Question: Sum up the contents of this chart in one sentence.
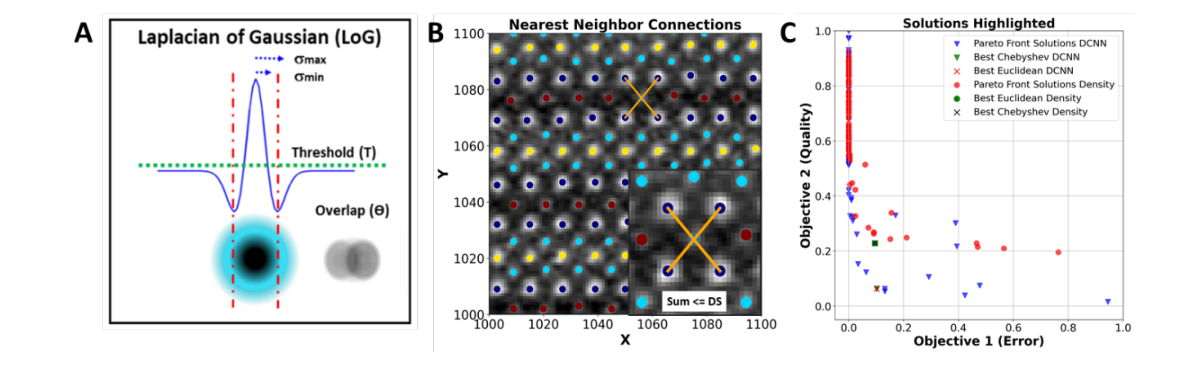
Answer: A) Laplacian of Gaussian Hyper-parameters, min_sigma (smin), max_sigma (smax),  num_sigma (snum), threshold (T), and overlap (q), B) Error function definition based on the  presence of atoms in areas that deviate from the structural arrangement of the YBCO lattice, C)  Pareto Frontier solutions with respect to Oracle-A, and Oracle-B). Each point represents an optimal  trade-off point such that improving one objective would compromise another. This balance  delineates the optimal hyper-parameter settings for the Laplacian of Gaussian (LoG) function,  achieved by finely tuning the competing objectives.